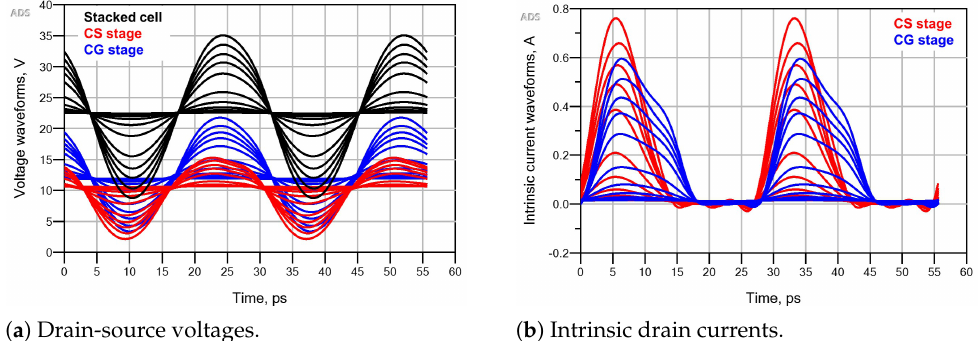
Figure 22. EM-simulated time-domain waveforms of the L GS